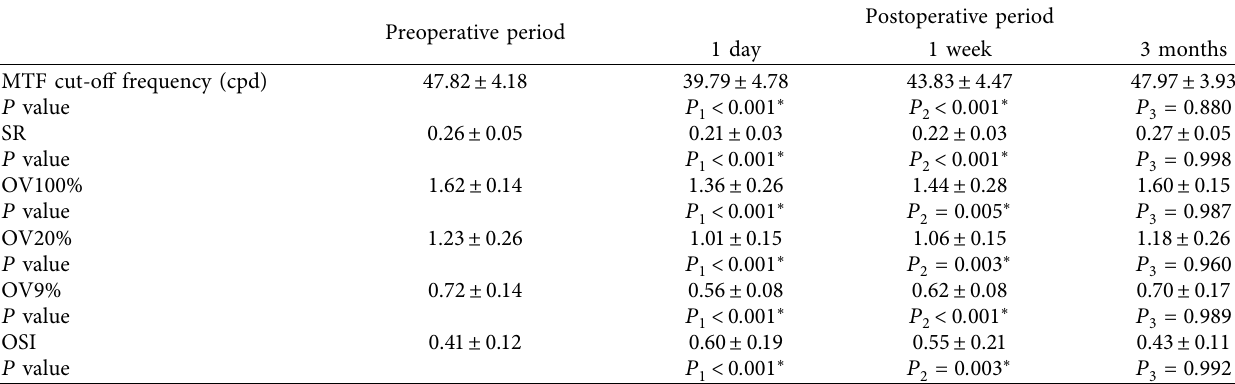
Table 4: Time courses of the optical quality parameters after traditional ICL